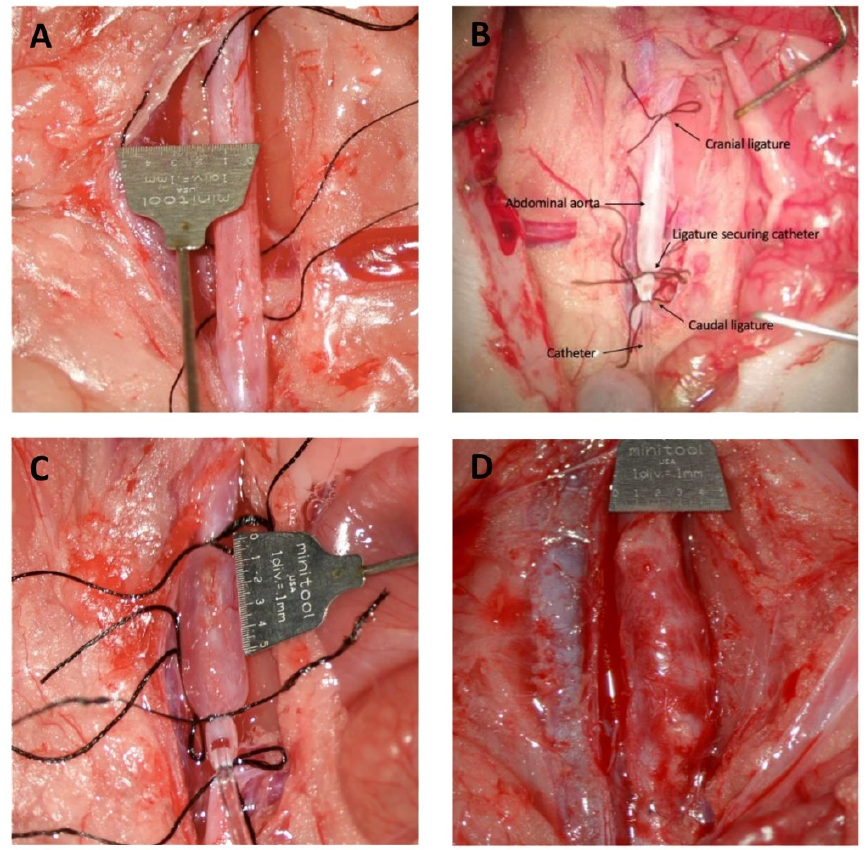
Figure 1. Induction of the surgical steps. ( A ) Isolated infrarenal aorta, ( B ) placing catheter in the infrarenal aorta, ( C ) intraluminal porcine pancreatic elastase infusion, ( D ) isolated AAA on day 28 post surgery.